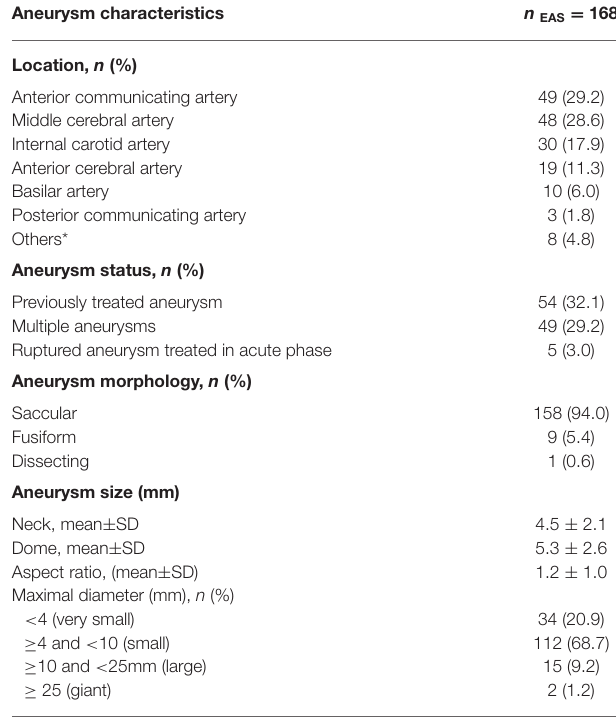
TABLE 2 | Aneurysm characteristics in the EAS